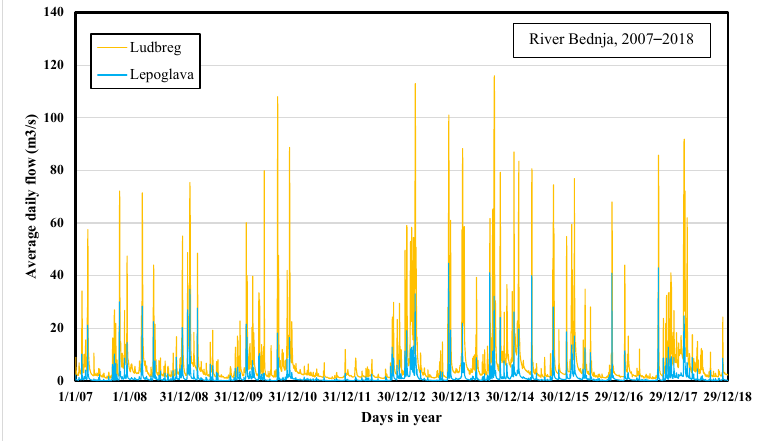
Figure 4. Comparison of the average daily flows for the measuring stations Ludbreg and Lepoglava.